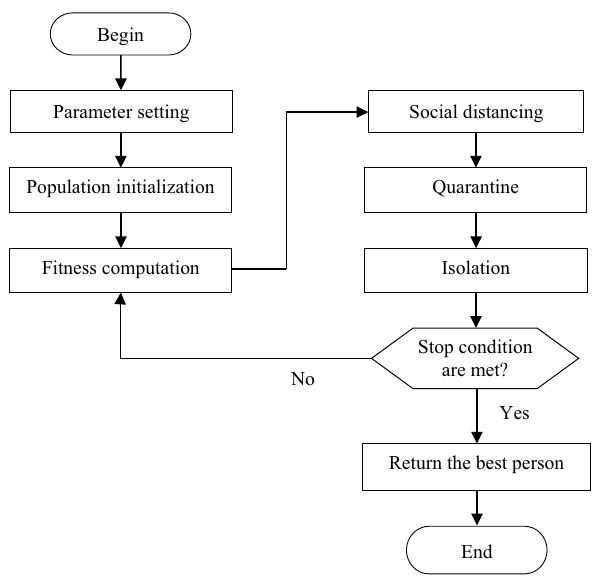
Fig. 3 Flowchart of the ACVO